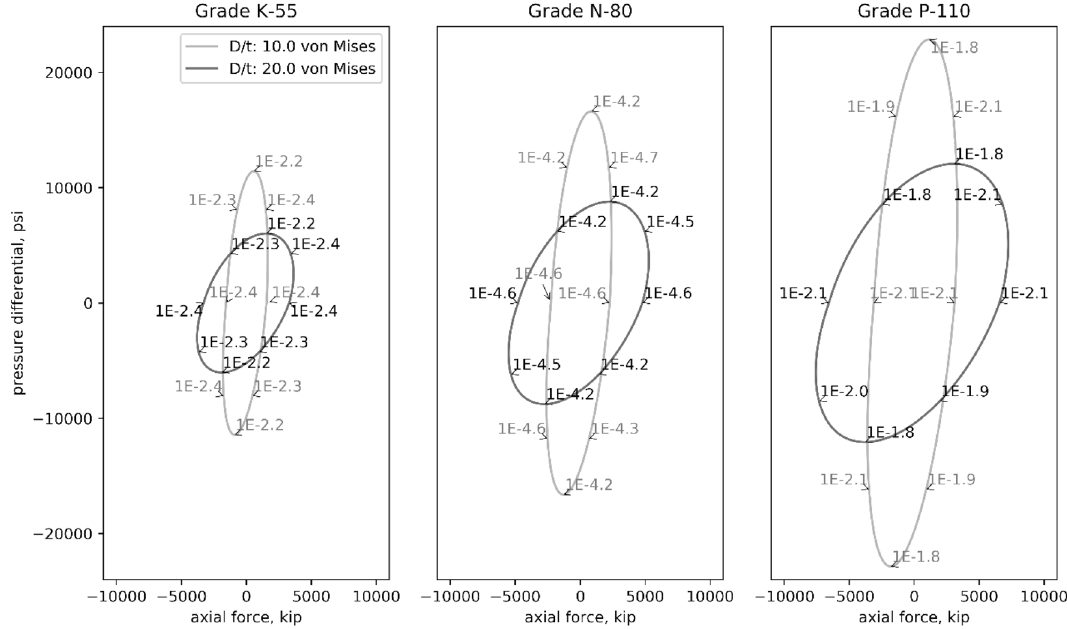
Fig. 11 Probabilities of exceeding SLS at von Mises ellipse limit state for grades K55, N80 and P110, with D ∕ t 10.0 and